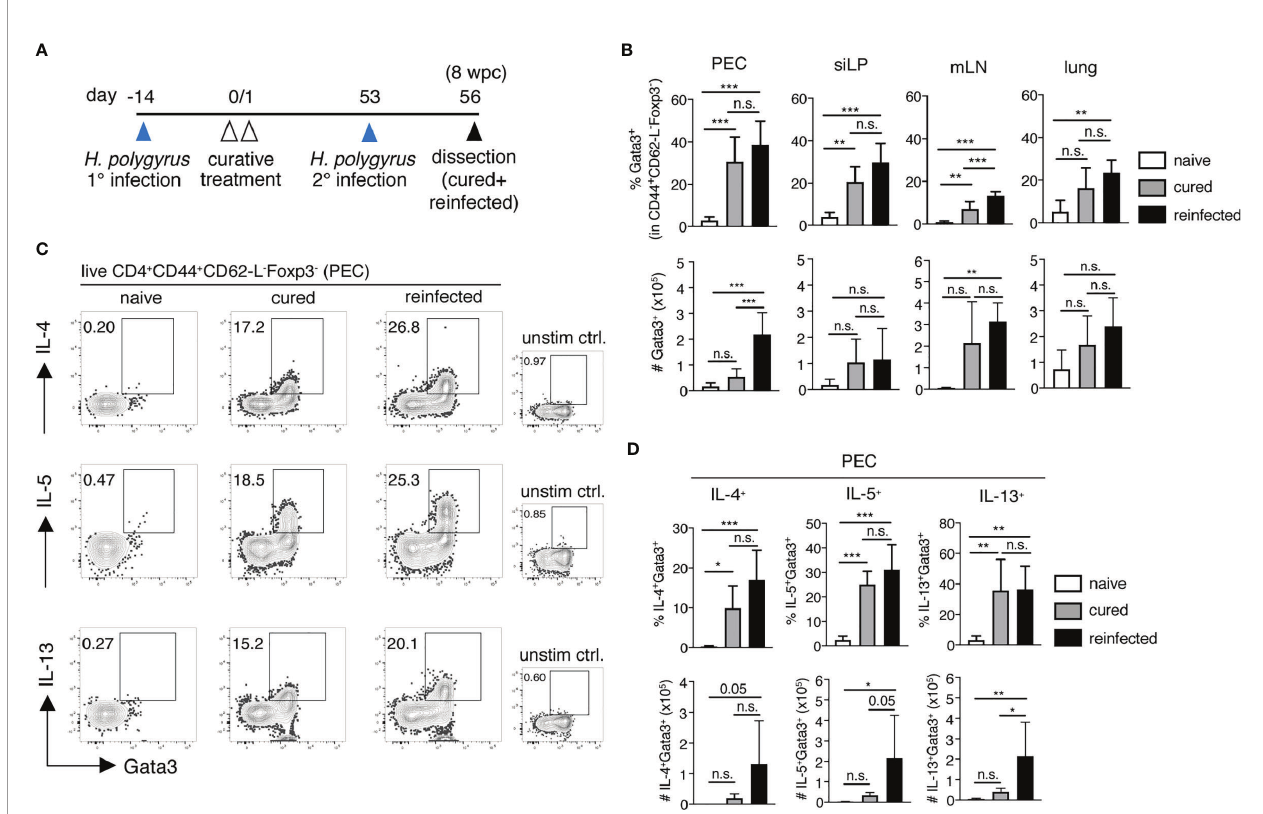
FIGURE 2 | The peritoneum harbours signi fi cant memory Th2 cell expansion and cytokine release following H. polygyrus challenge infection. (A) Experimental set- up. Brie fl y, mice were infected via oral inoculation with 225 infective L3 H. polygyrus larvae and were cured of infection 14 days later via oral administration of 2mg/ mouse pyrantel pamoate anti-helminthic on two consecutive days. All the cured mice were then allowed to rest. 8 weeks post-cure (day 53), a number of cured mice received a challenge H. polygyrus infection (reinfected group) and were sacri fi ced 3 days post-challenge (day 56) alongside un-challenged cured mice (cured group) and naïve controls for further analysis. (B) Frequencies (top panel) and absolute cell numbers (bottom panel) of Gata3 + CD4 + CD44 + CD62-L - Foxp3 - memory Th2 cells in the peritoneal cavity (PEC), small intestinal lamina propria (siLP), mesenteric lymph nodes (mLN) and lungs of naïve, cured and reinfected mice. (C) Representative FACS plots showing cytokine + PEC-resident memory Th2 cells following in vitro PMA/Ionomycin stimulation and corresponding unstimulated controls. (D) Frequencies (top panel) and absolute cell numbers (bottom panel) of IL-4 + , IL-5 + and IL-13 + memory Th2 cells in the PEC of naïve, cured and reinfected mice. The data are pooled from two independent experiments with n = 3-5 mice per group. Statistical analysis was done using one-way ANOVA combined with Tukey ’ s multiple comparison test. * p < 0.05, ** p < 0.01, *** p < 0.001. n.s., not signi fi